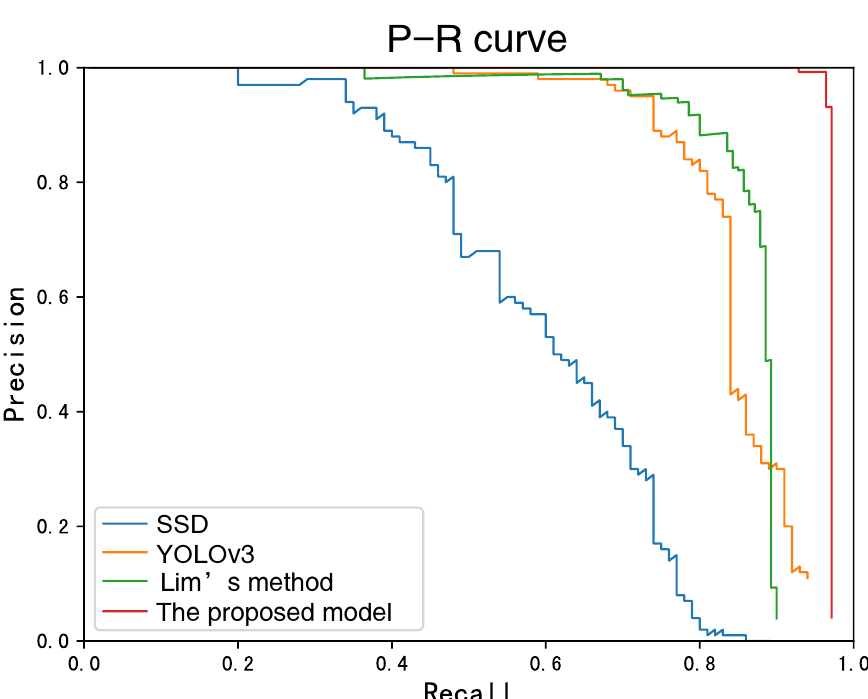
Figure 16. P-R curve of the four object detection